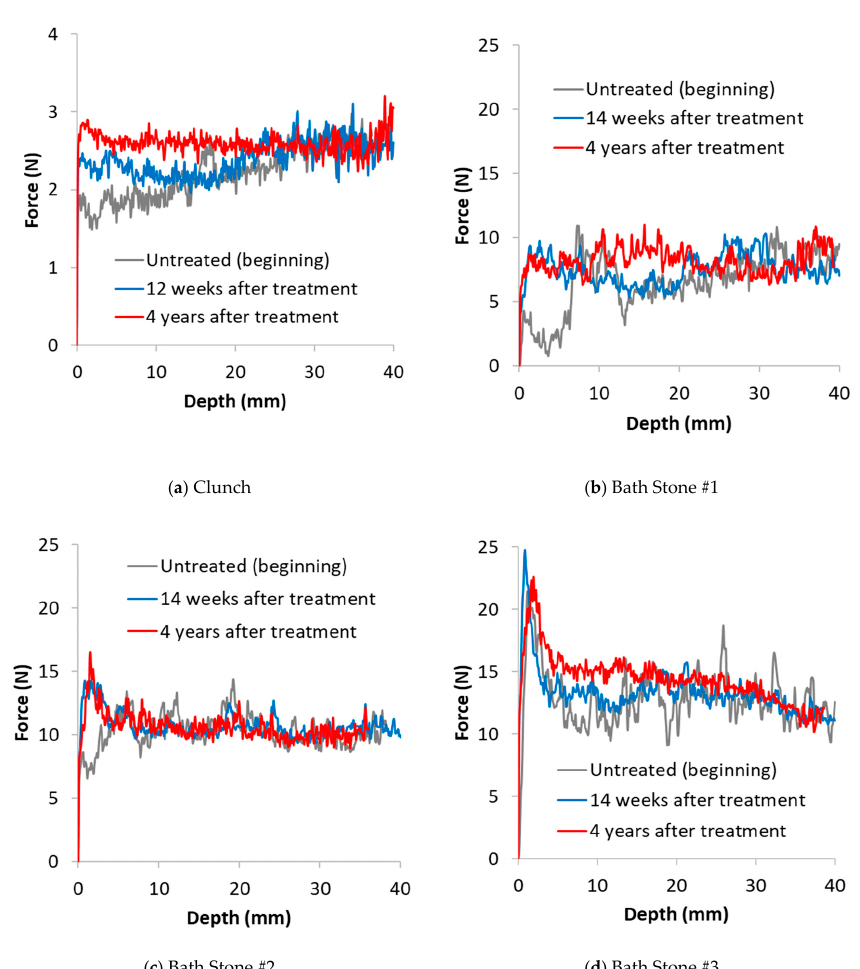
Figure 4. Drilling resistance vs. Drilling depth untreated (beginning), 12 weeks after treatment and 4 years after treatment of stone specimens where nanolime had a positive consolidating effect. ( a ) Clunch; ( b ) Bath Stone #1; ( c ) Bath Stone #2; ( d ) Bath Stone #3.